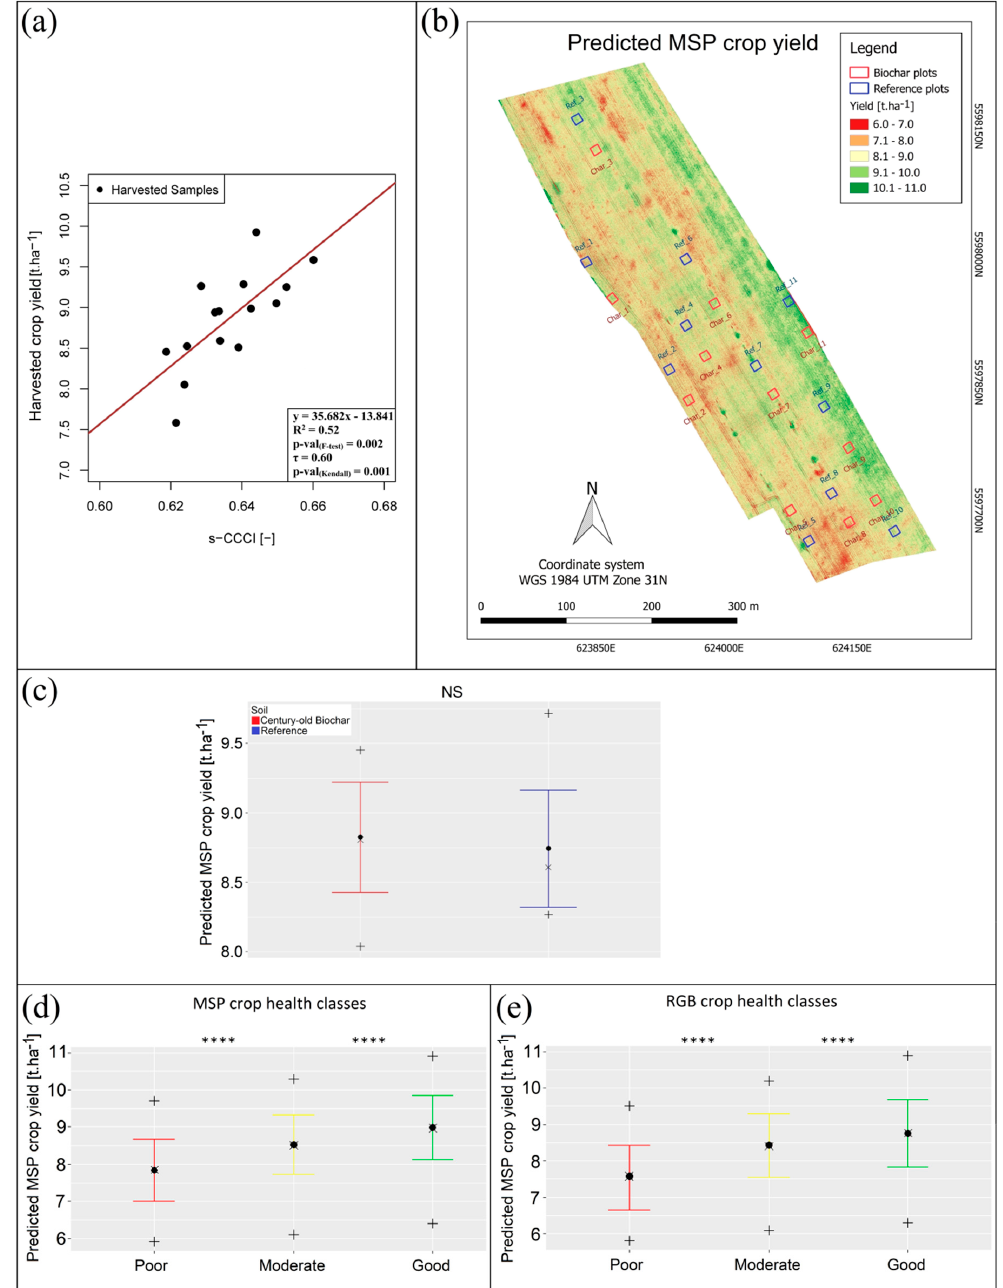
Figure 11. ( a ) Relationship between the multispectral (MSP) simplified canopy chlorophyll content index (s-CCCI) on 24 June and the harvested crop yield on 20 July. The black circles represent the harvested samples and the brown line indicates the linear regression fit. ( b ) Map of the predicted MSP crop yield computed from the relationship between the MSP s-CCCI and the harvested crop yield. ( c ) A comparison of the predicted MSP crop yield of all of the 11 century-old biochar plots (red) versus the 11 reference plots. The black circle and cross represent the mean and median MSP crop yield, respectively. The error-bar represents the corresponding standard deviation. The bottom and top black pluses ( + ) indicate the minimum and maximum MSP crop yield, respectively. A comparison of the predicted MSP crop yield of the good (green), moderate (yellow), and poor (red) crop health